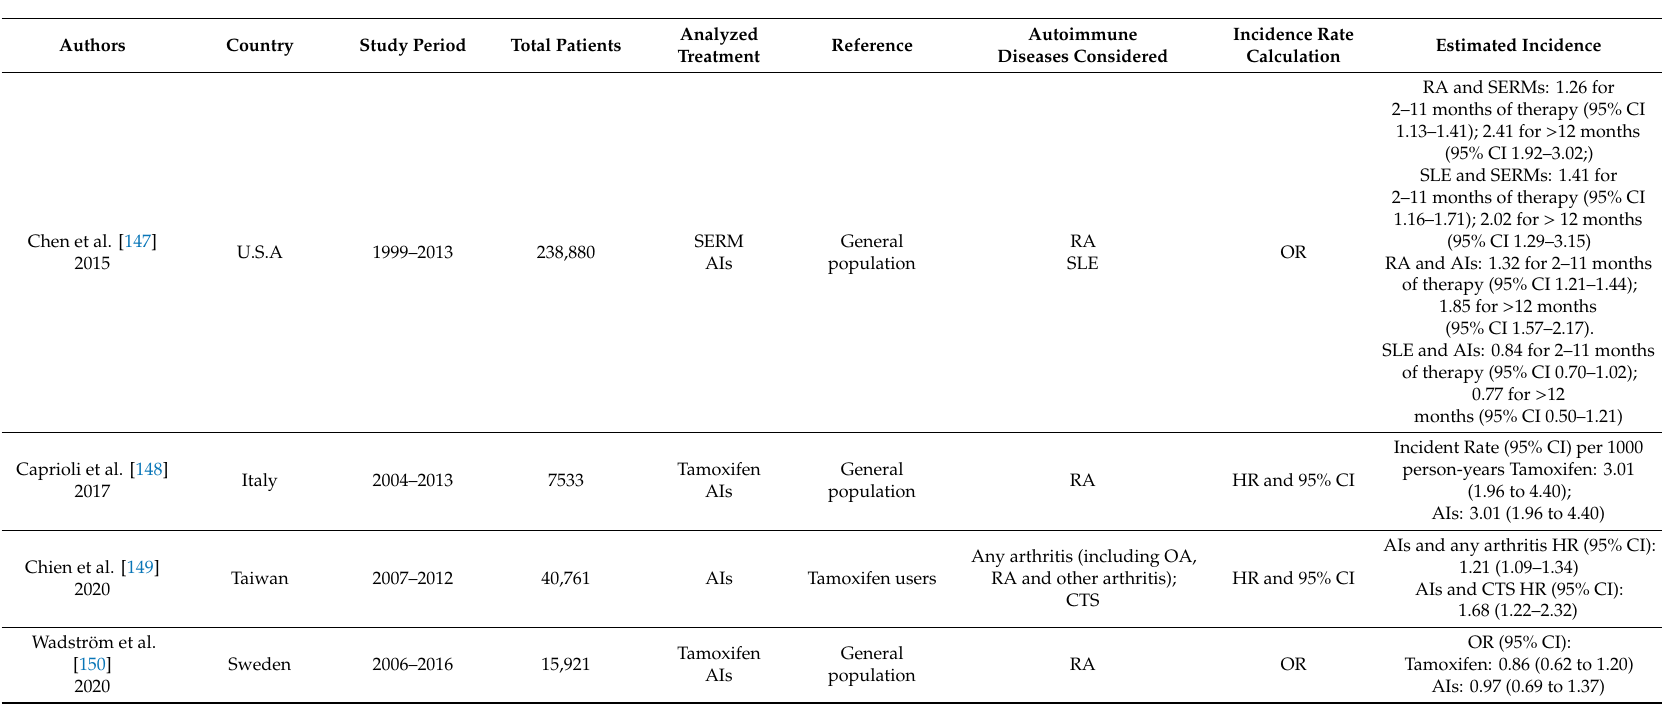
Table 4. Summary of the studies evaluating the incidence of rheumatic diseases during hormone therapy for breast